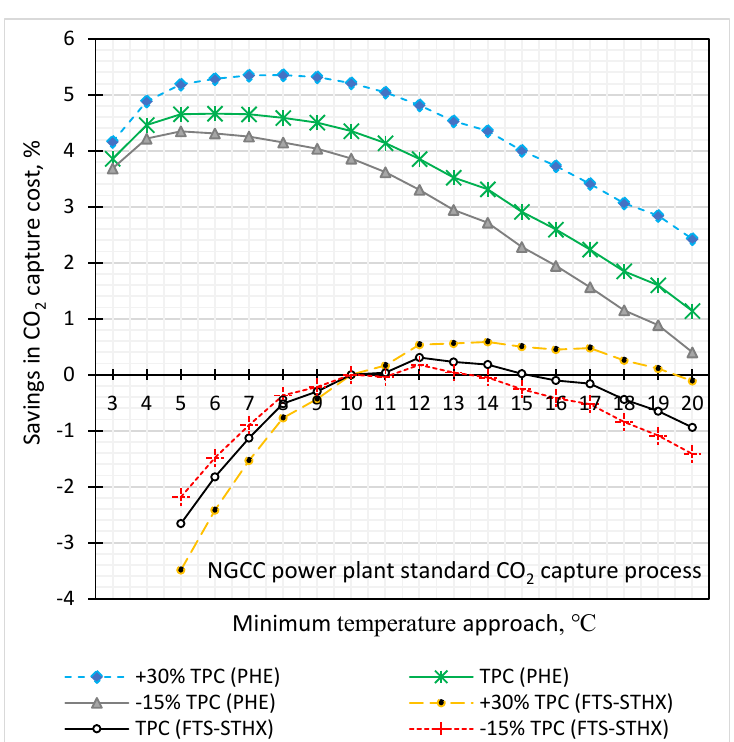
Figure 21. Sensitivity analysis of TPC on the energy and heat exchanger costs trade–off analyses at different ∆ T min for different heat exchanger types in a standard CO 2 capture from cement flue gas.